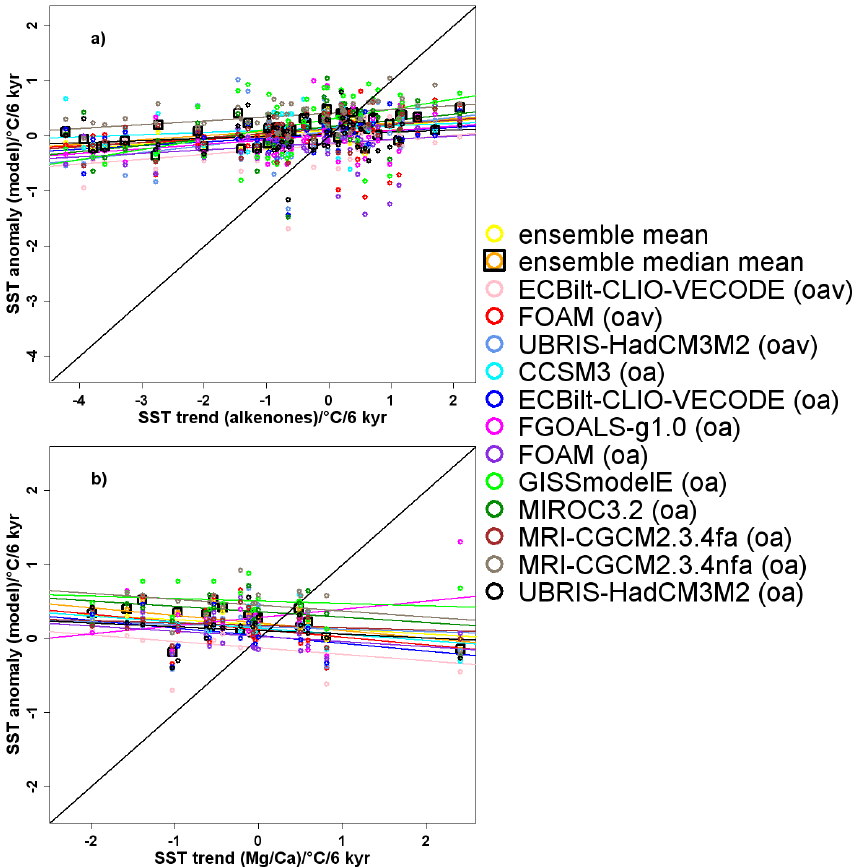
Figure 7 Fig. 7. (a) Global alkenone-based SST trends compared to simulated annual mean SST anomalies in the models listed in PMIP2. The black squares represent the ensemble median mean and the colours correspond to a specific model. (b) Global Mg/Ca-based SST trends compared to the models of the PMIP2 annual mean SST